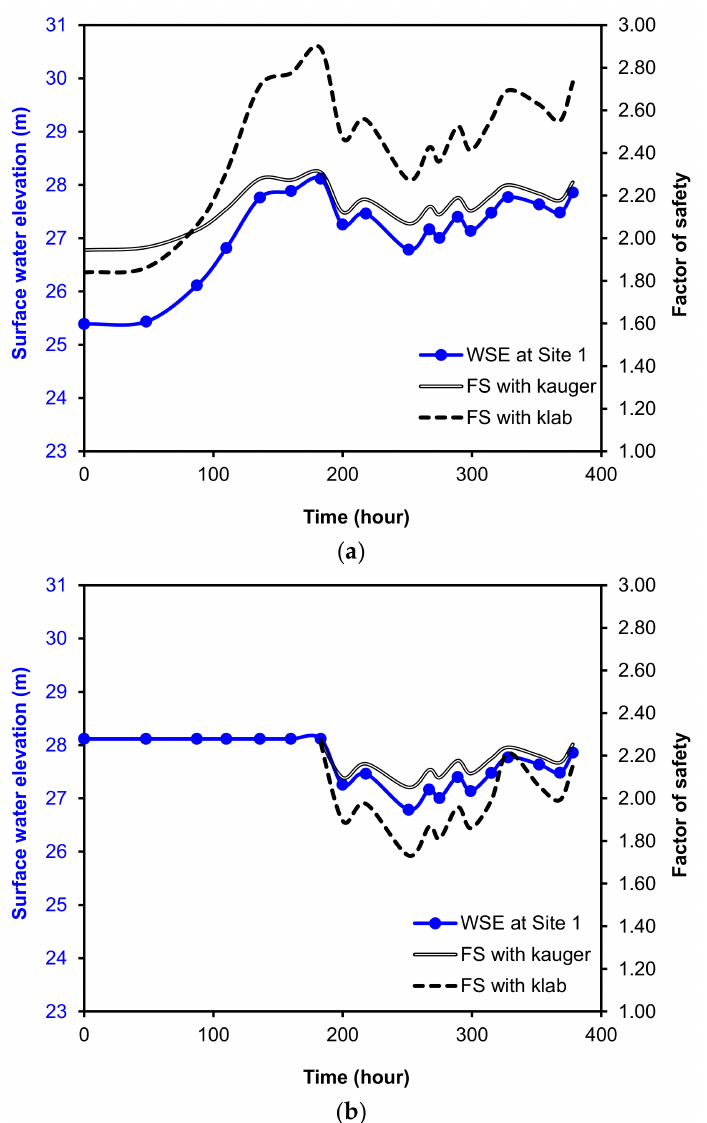
Figure 12. Changes in the factor of safety during continuous peaking events: ( a ) low initial phreatic surface (initial WSE = 25.4 m), and ( b ) high initial phreatic surface (initial WSE = 28.1